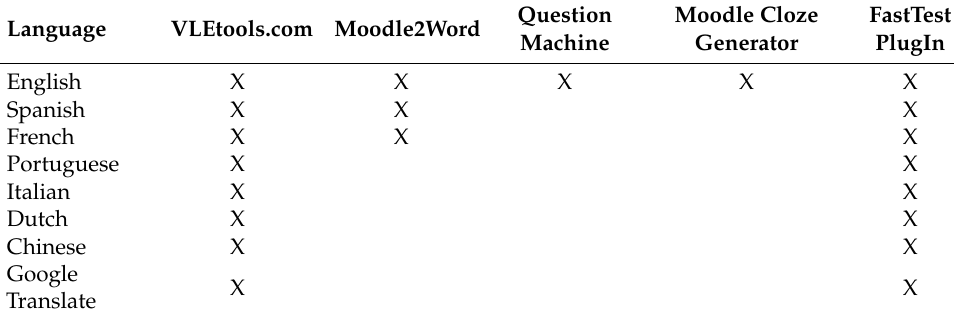
Table 6. Comparison of available